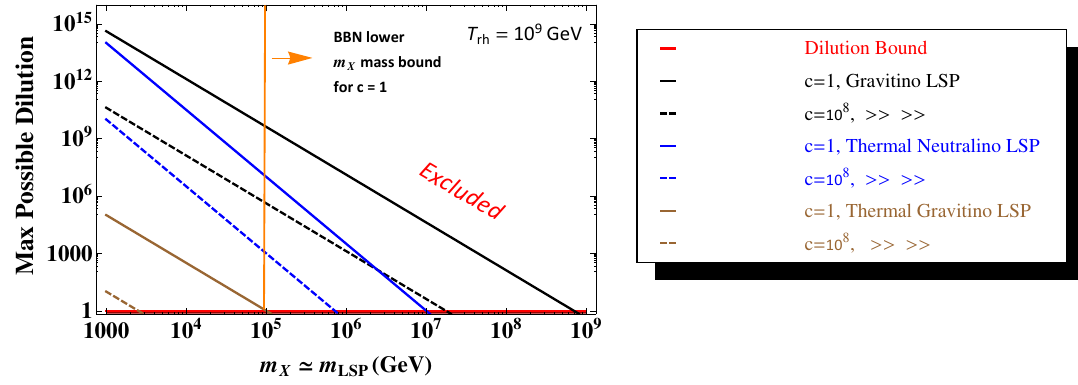
Figure 5 . The maximum possible dilution size, caused by a scalar X condensate, with respect to the LSP mass, for gravitino LSP (black, brown) and neutralino LSP (blue). We have made the conservative assumption m X ’ m LSP that maximizes the diluter X lifetime. In the area above the lines it is (cid:10) < h 2 =D X > 0 : 12, hence it is an excluded parameter area. The solid and dashed LSP lines correspond to c = 1 and c = 10 8 according to the parametrization (4.7). For a gravitationally decaying diluter (c=1), the thermal gravitino scenario (brown solid line) is excluded because the X spoils the BBN predictions. The plot demonstrates the decrease of the dilution e(cid:14)ciency for large supersymmetry breaking scale and T rh = 10 9